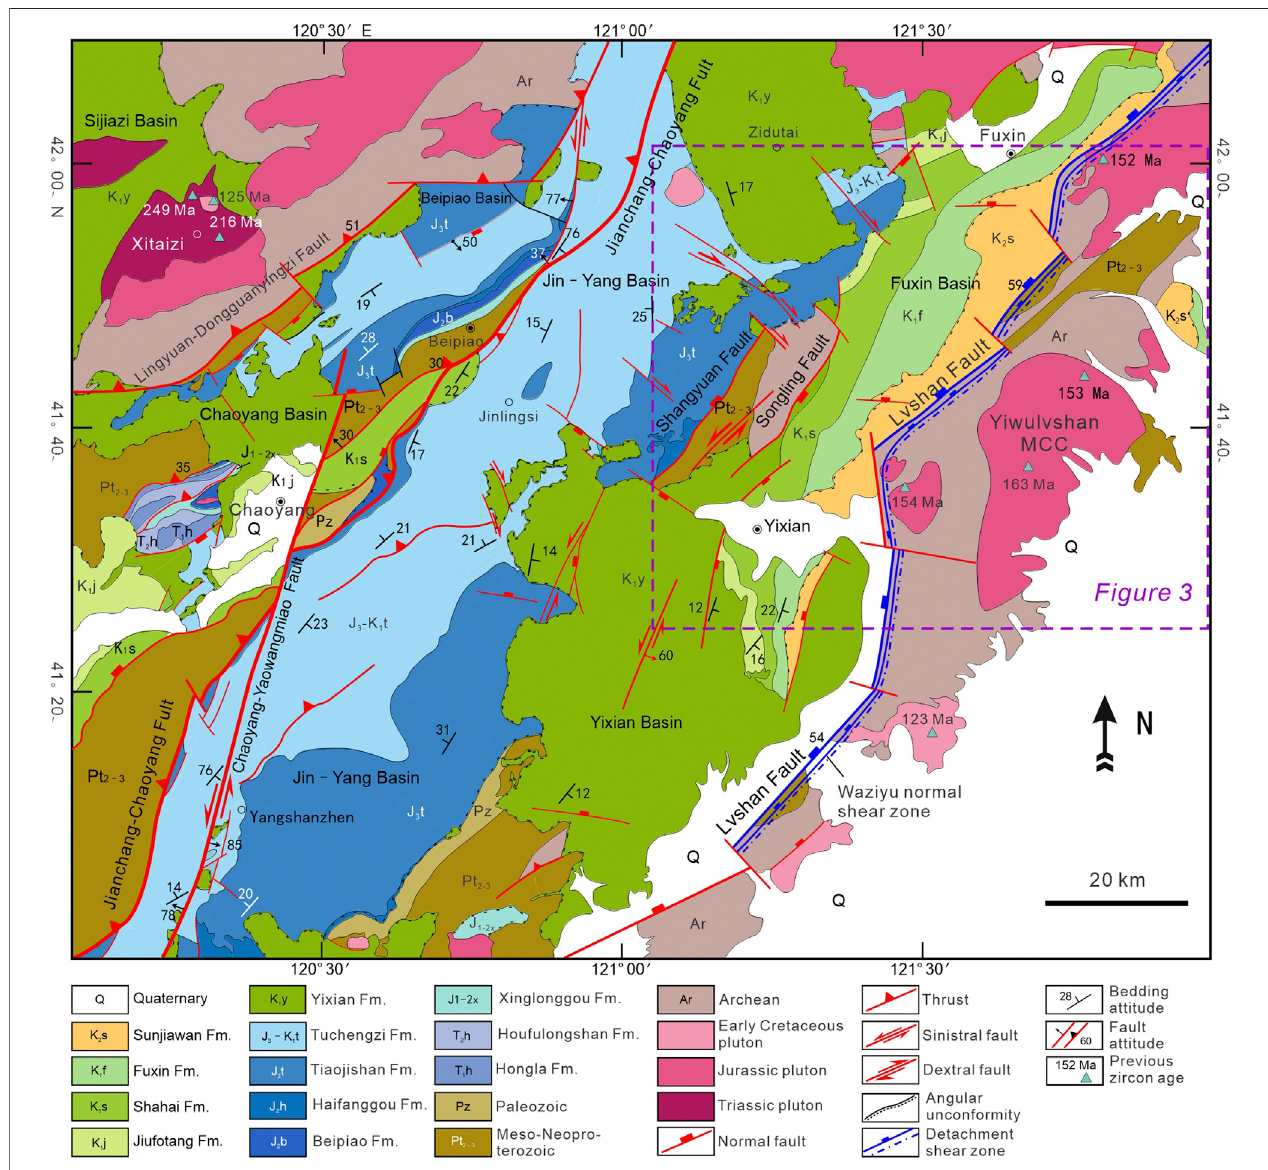
FIGURE 2 | Geological map of the Yiwulvshan metamorphic core complex and Fuxin supradetachment basin in the eastern Asian margin (modi fi ed after Su et al., 2020).